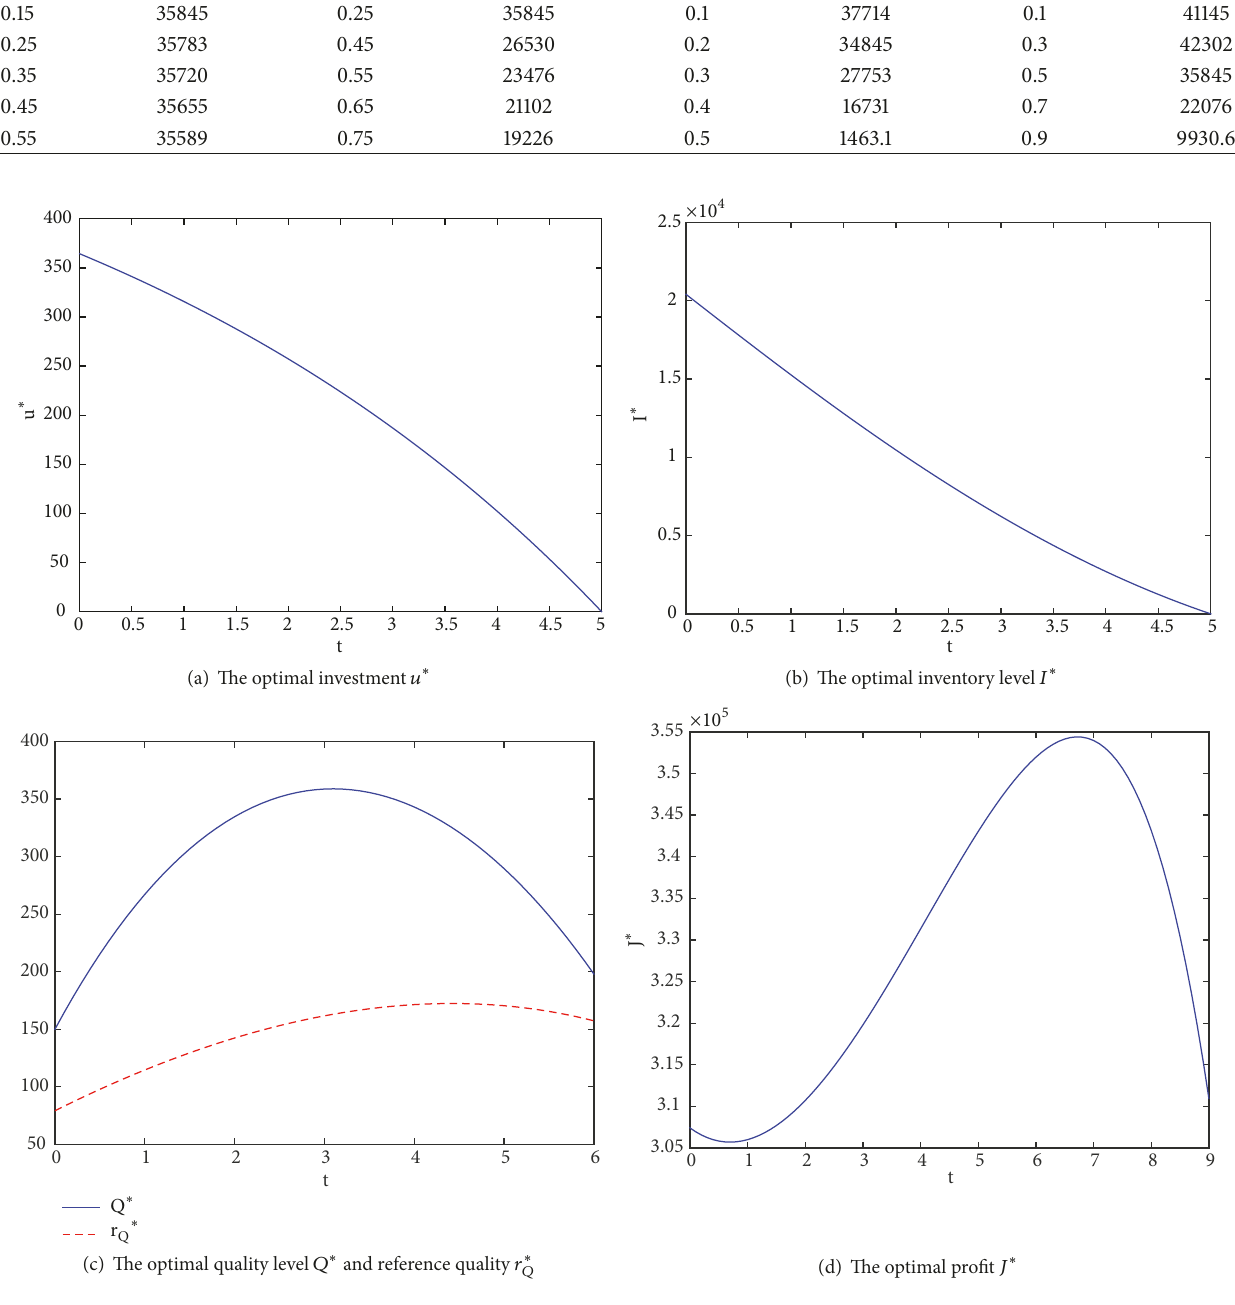
Figure 1: The optimal strategies versus 𝑇